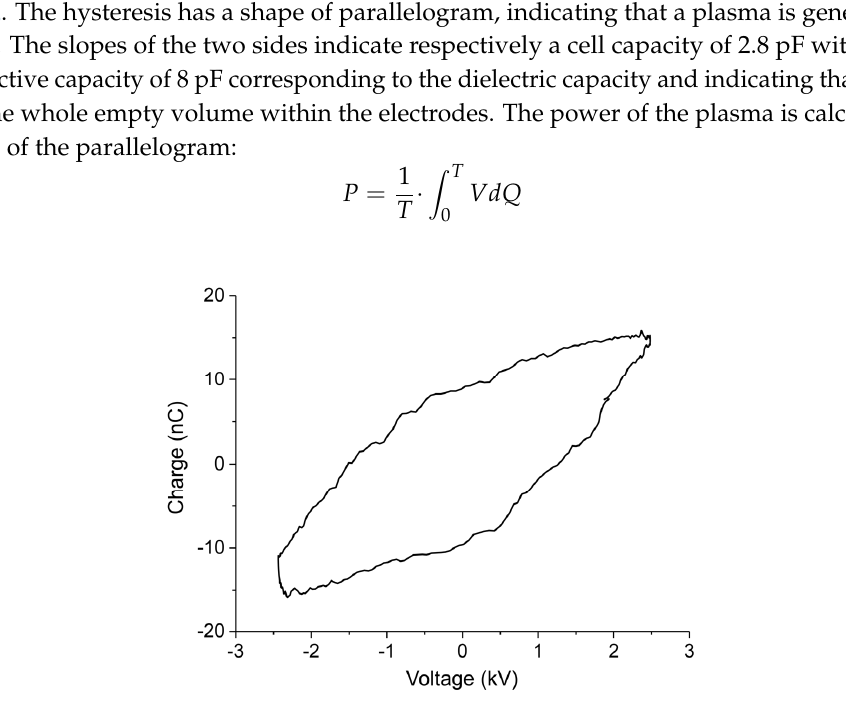
Figure A12. Lissajous plot of 1.5 W plasma applied on the CaCO 3 and Al 2 O 3 mixture with 3200 ppm of CO 2 in Ar.